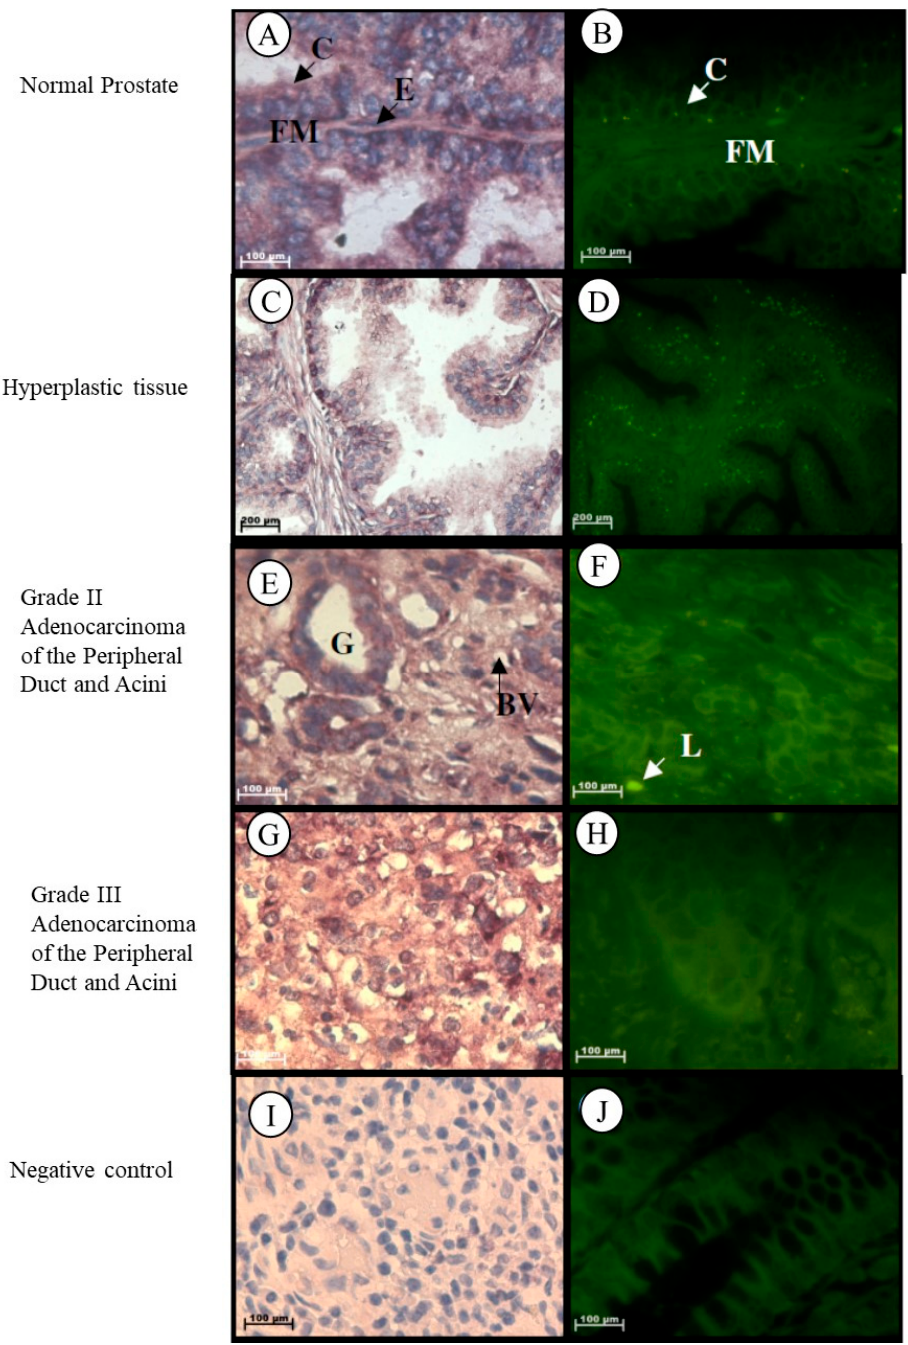
Figure 1. Localization of Tspo mRNA in healthy and diseased prostate tissues: In normal tissue ( A , B ) Tspo mRNA is localized to the cytoplasm of the inner columnar epithelium ( C ) and in the cytoplasm and elastic fibres (FM) and in the nuclei of fibroblasts of the fibromuscular stroma. Transcription of Tspo increases in hyperplastic tissue, ( C , D ) as shown by the increase in fluorescence intensity ( D ). In Grade II adenocarcinoma ( E , F ) Tspo mRNA is localized within the cytoplasm of cuboidal to low columnar epithelial cells lining glands (G), in the collagen fibres located in the stroma and in the nuclei and cytoplasm of lymphocytes (L) and endothelial cells lining blood vessels located in the surrounding stroma. In Grade III adenocarcinoma ( G , H ) Tspo mRNA is found in the cytoplasm of tumor cells that grow in sheets. Negative control for the subcellular localization of Tspo mRNA ( I , J ). Sense probes were used to probe tissue preparations. Tissues are magnified at 1000×.